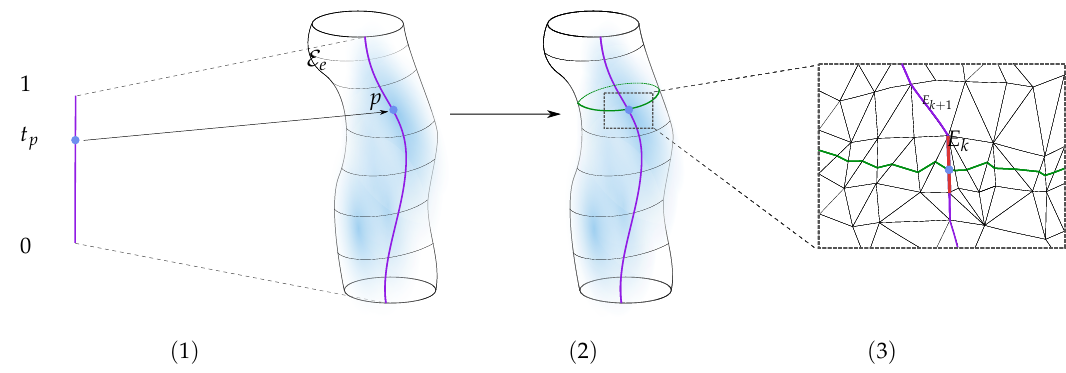
Figure 13. An illustration of the data retrieval procedure. (1) A value t p is selected from the interval ( 0,1 ) . (2) This value is used to determine a point p on the Reeb graph edge E e . (3) This point is contained in an edge E k on the mesh M . This edge is used to determine the circle Cr p